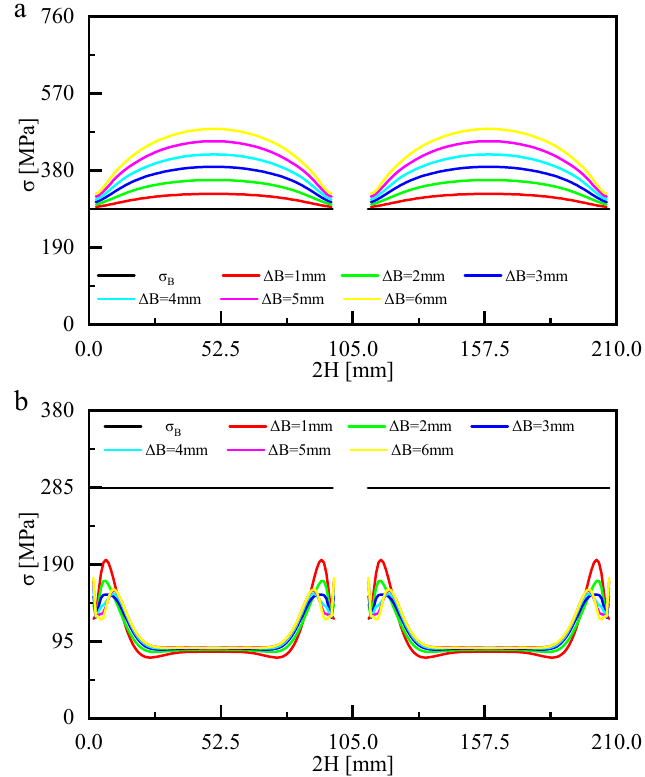
Figure 13. Von Mises stress ( a ) and residual stress ( b ) of bi-segment bulged hulls with various bulging magnitudes as obtained from numerical analysis.